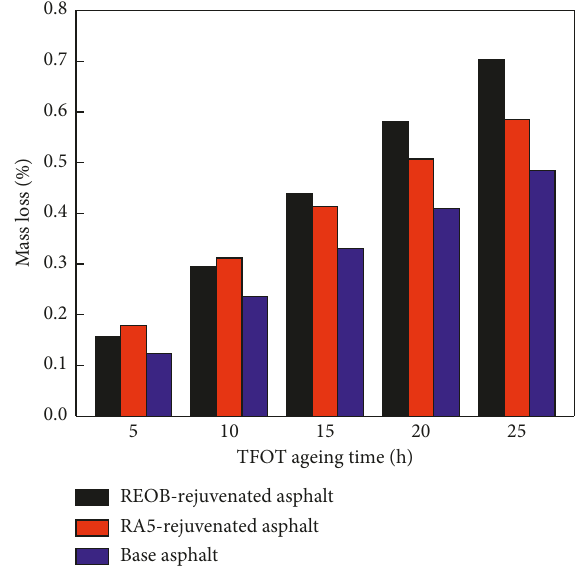
Figure 3: Relations between mass loss and TFOT ageing time for three kinds of asphalt. Table 4: Viscosities of the three kinds of asphalt at 60 ° C under different extended TFOT ageing times (MPa ·